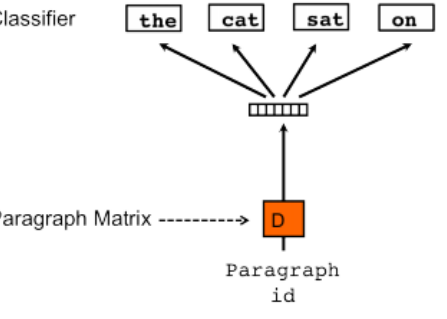
Figure 2. Distributed Bag of Words Paragraph Vector